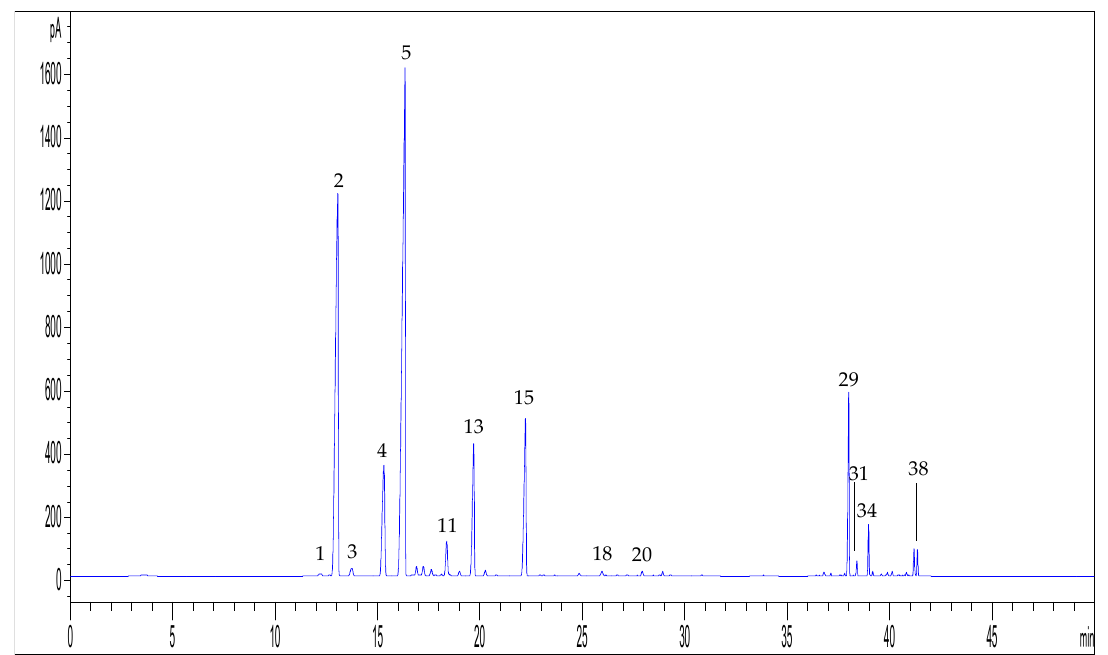
Figure 12. Representative GC-FID chromatogram obtained by using the HS-SPME method optimised for volatile compounds from hemp inflorescences (sample C3). For peak numbering, see Table 4 .